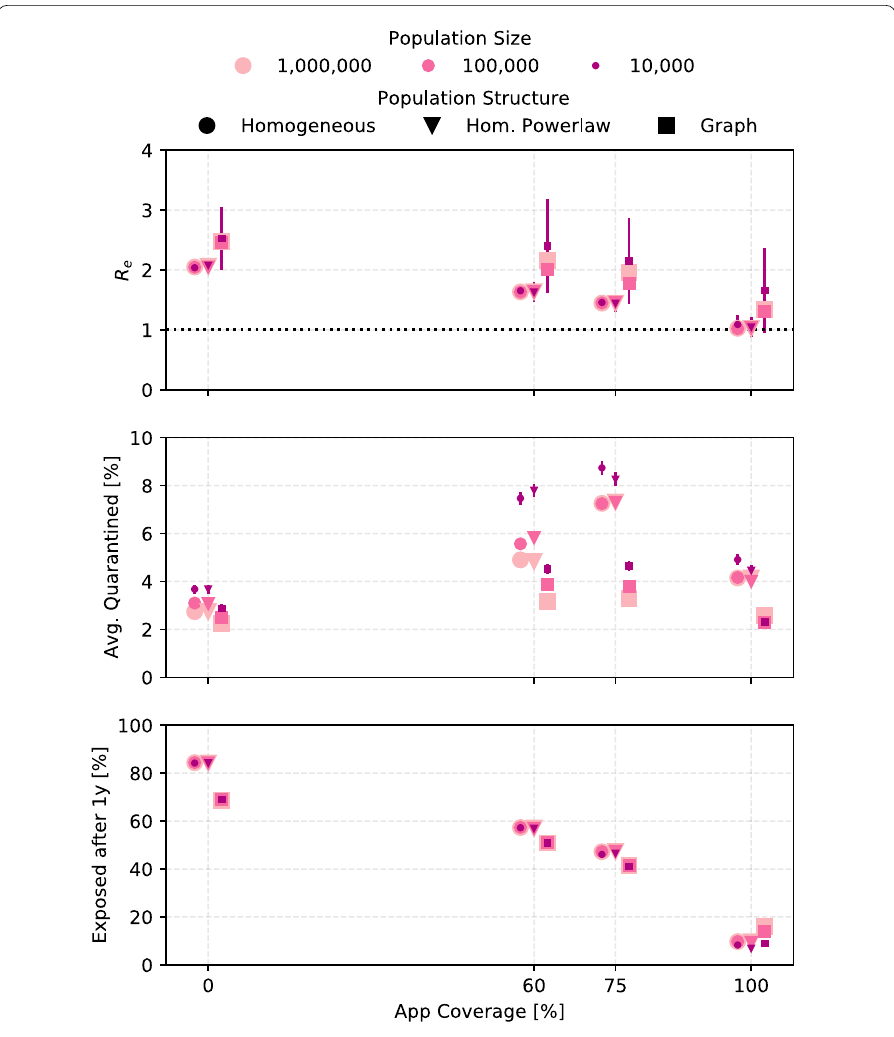
Figure 14 The sensitivity of the outcomes to the size and the structure of the simulated population is shown. The three population structures (described in Sect. 2.1) correspond to the homogeneous population with a gamma distribution (Eq. (3)) describing the number of contacts per day, a homogeneous distribution using the power law (Eq. (4)) for the number of contact per day, and the social graph population. Settings are R 0 = 3, α · f m = 0.6, η DCT = 1, trace uninfected = true. For the 10,000 people population, outcomes have large statistical fluctuations and error bars show the error on the mean. For the other points, the error bars are smaller than the marker